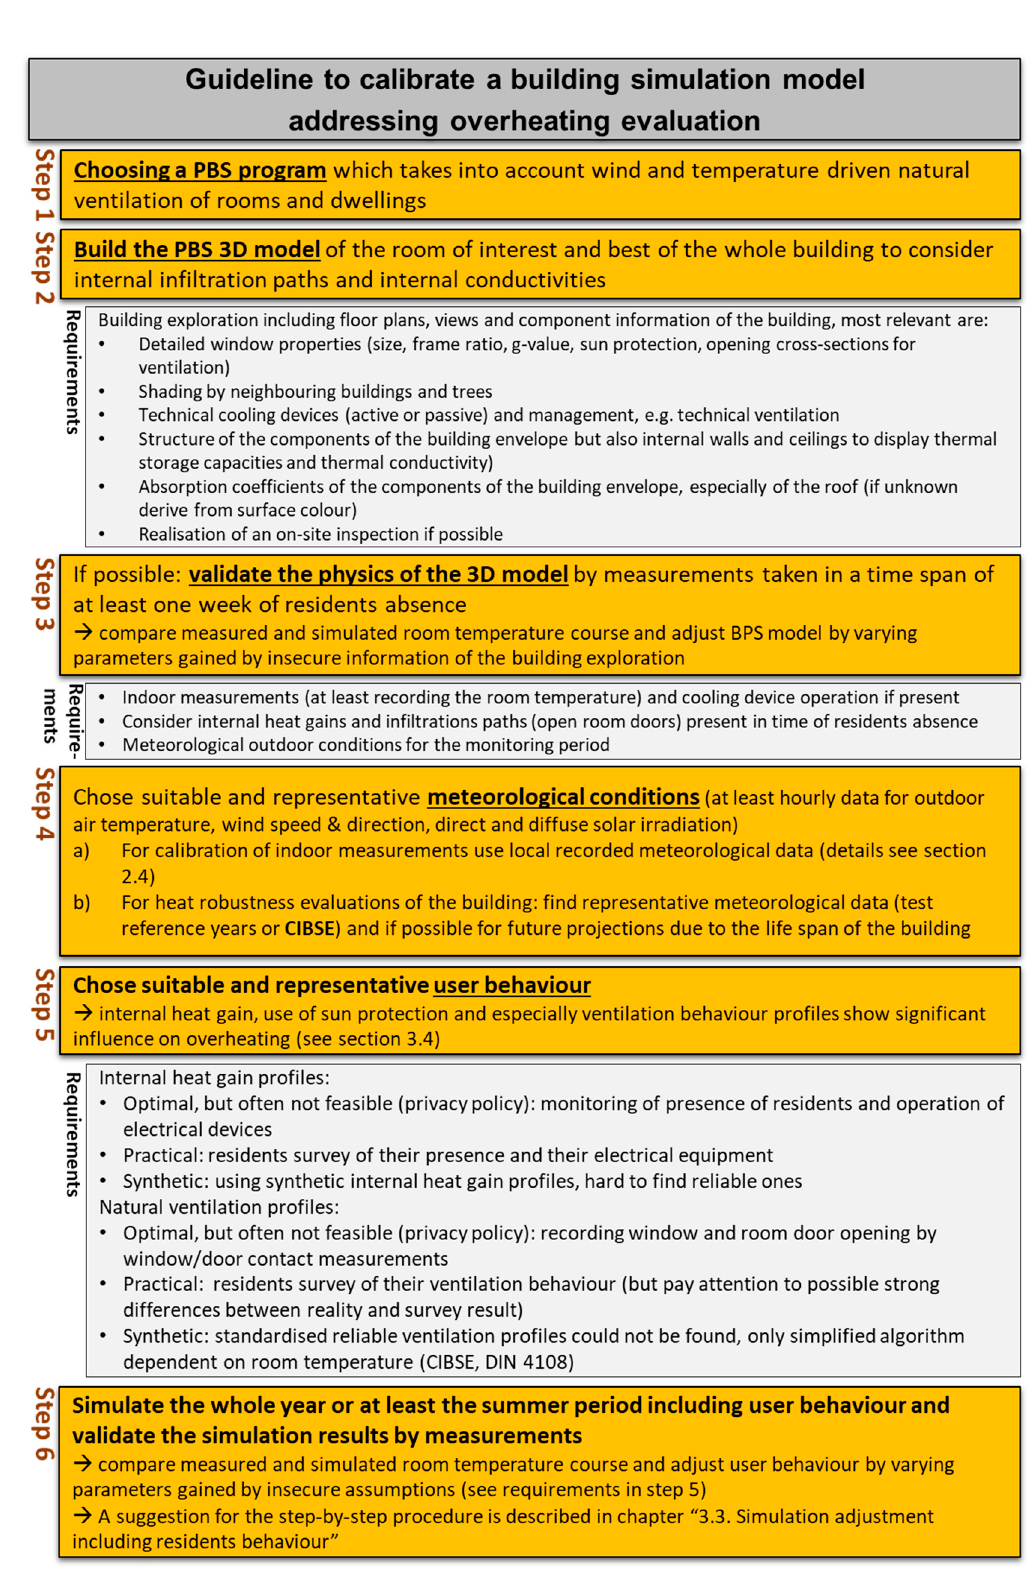
Figure 8. Schematic of the guideline for simulation model calibration of multi-residential buildings addressing overheat- ing evaluation.